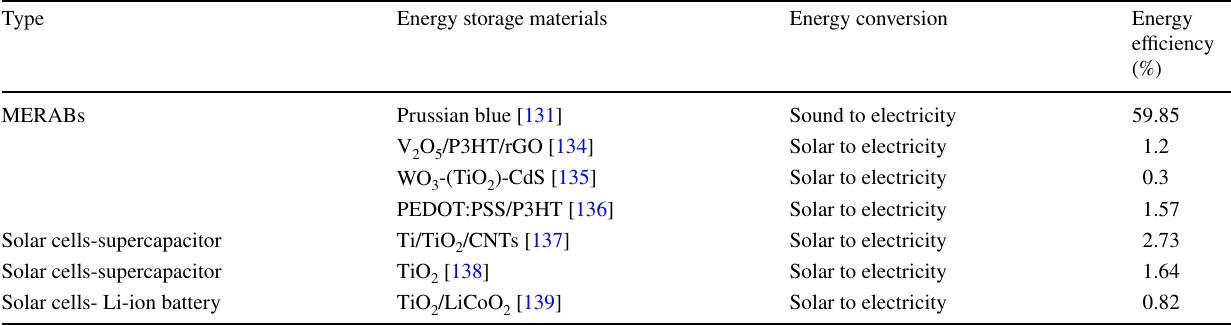
Table 1 A summary of the conversion efficiency of integrated MERABs systems and their similar integrated supercapacitor/battery systems